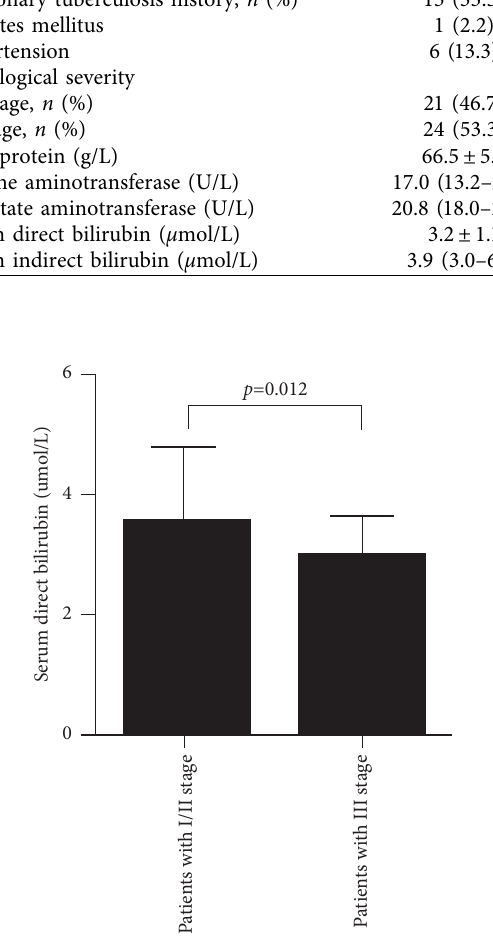
Figure 1: Te comparison of serum direct bilirubin between stage I/II pneumoconiosis and stage III